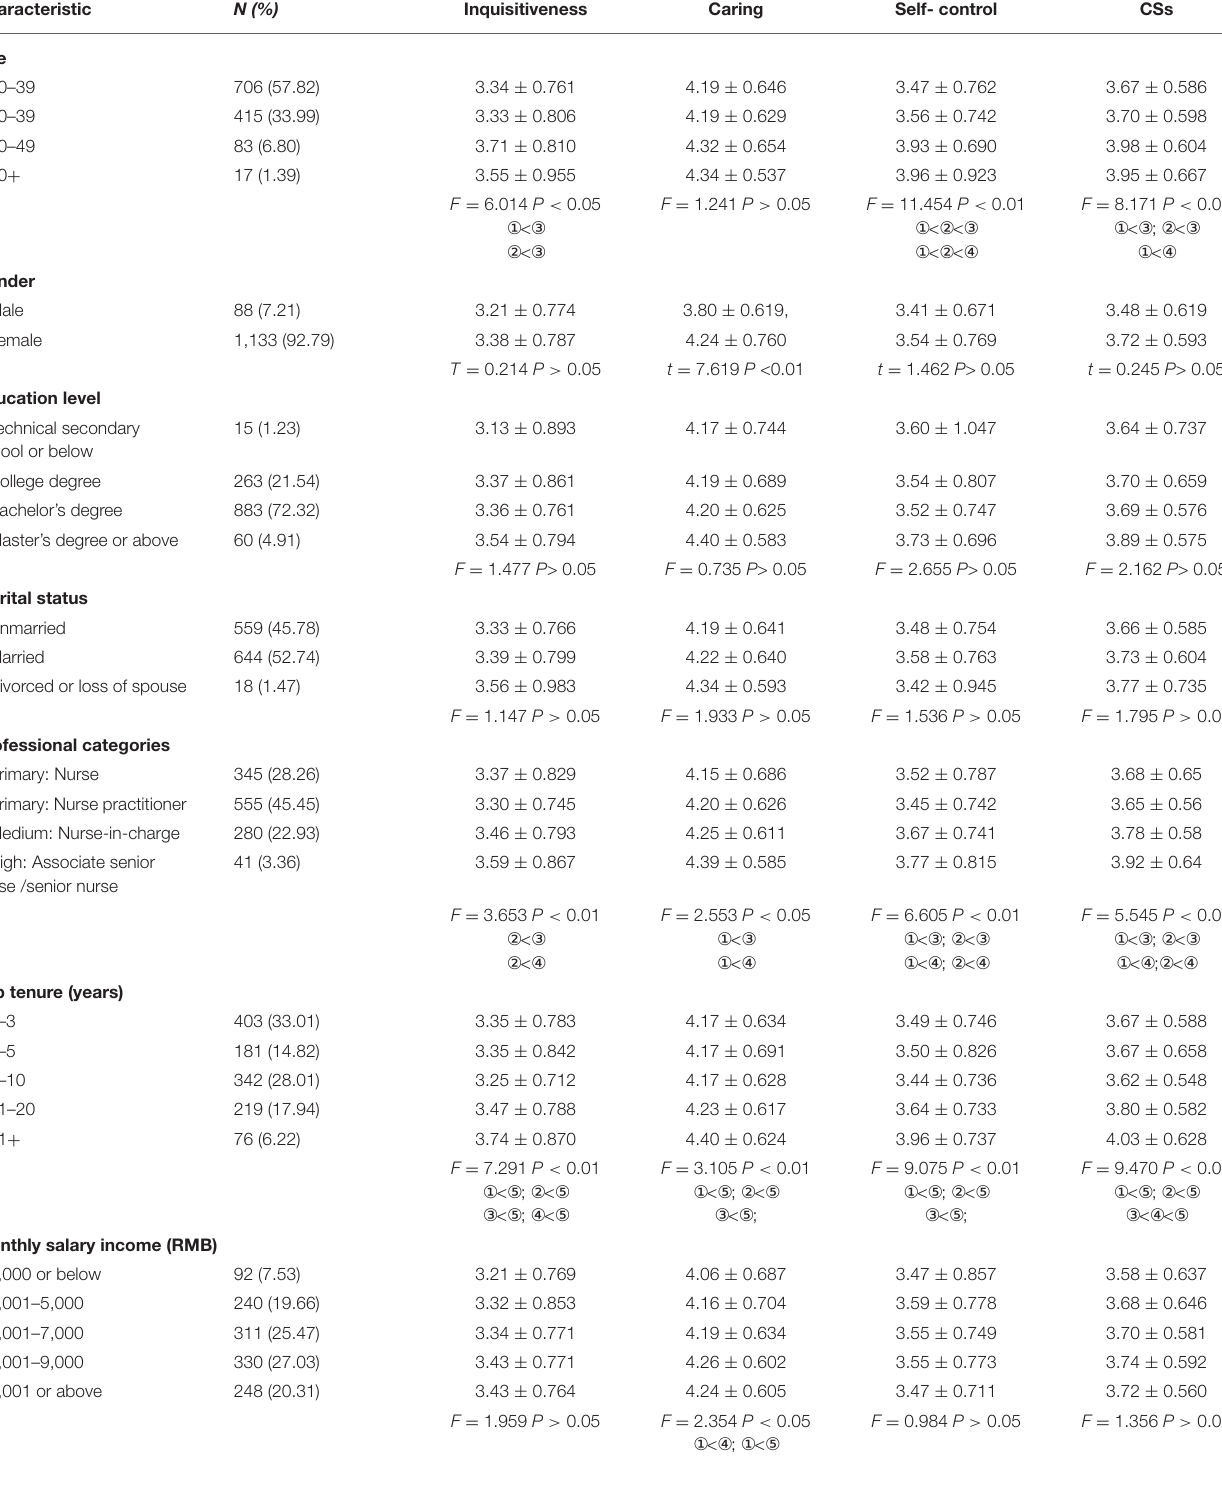
TABLE 1 | Characteristics of the participants and sociodemographic differences in the three-dimensional inventory of character strengths ( n = 1,221).